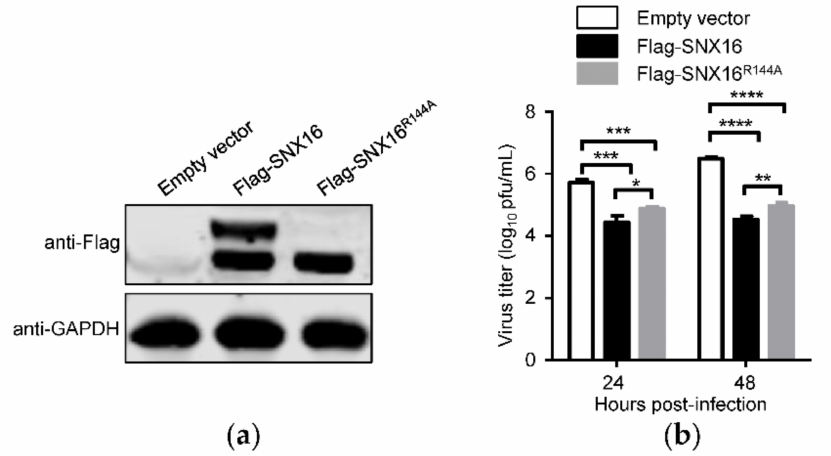
Figure 6. R144A mutation of SNX16 attenuates its inhibitory effect on IAV replication. ( a ) A549 cells were transfected with plasmids expressing empty vector, Flag-SNX16, and Flag-SNX16 R144A . The expression of SNX16 was detected by Western blotting. ( b ) The transfected A549 cells, as in ( a ), were infected with WSN (H1N1) virus at an MOI of 0.01. Supernatants were collected at the indicated time points and virus titers were evaluated by plaque assay ( n = 3). *, p < 0.05; **, p < 0.01; ***, p < 0.001; ****, p < 0.0001. Data are representative of three independent